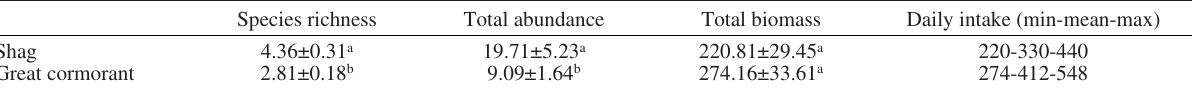
Table 2. – Shag and great cormorant species richness, total prey abundance and biomass per pellet sample (mean±standard error), and daily biomass intake range [g day –1 , as estimated according to Johnstone et al. (1990): 1-2 pellets day –1 ]. Different superscript letters indicate significant differences.